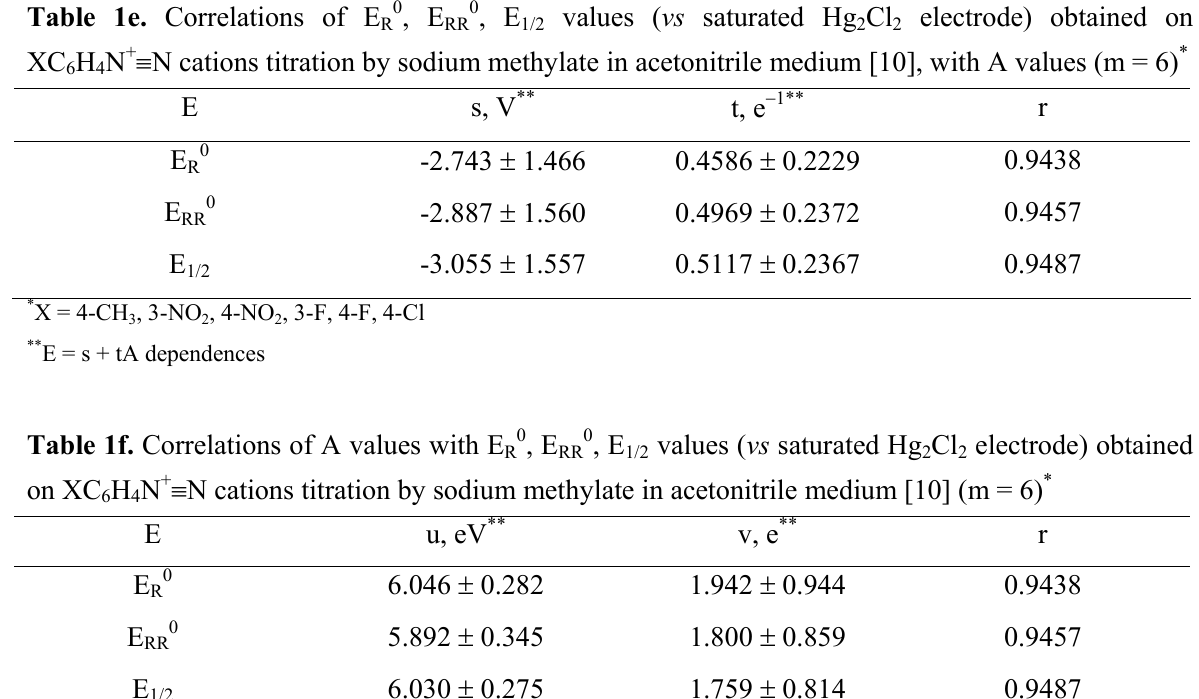
Table 1e. Correlations of E R0 , E RR0 , E